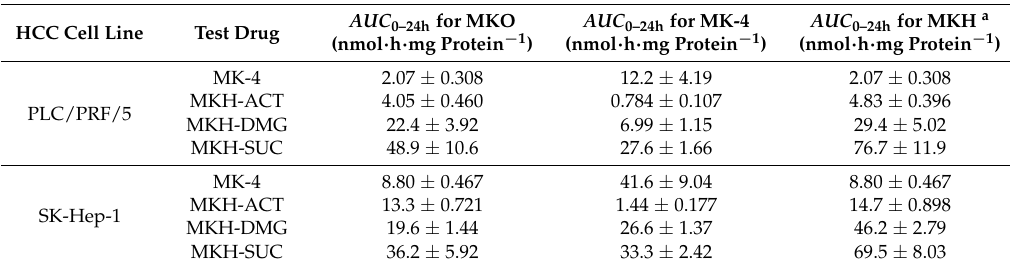
Table 3. Area under the intracellular concentration versus time curve ( AUC ) after treatment with MK-4 or MKH-ester prodrugs in HCC cell lines. Doses are 25 µ